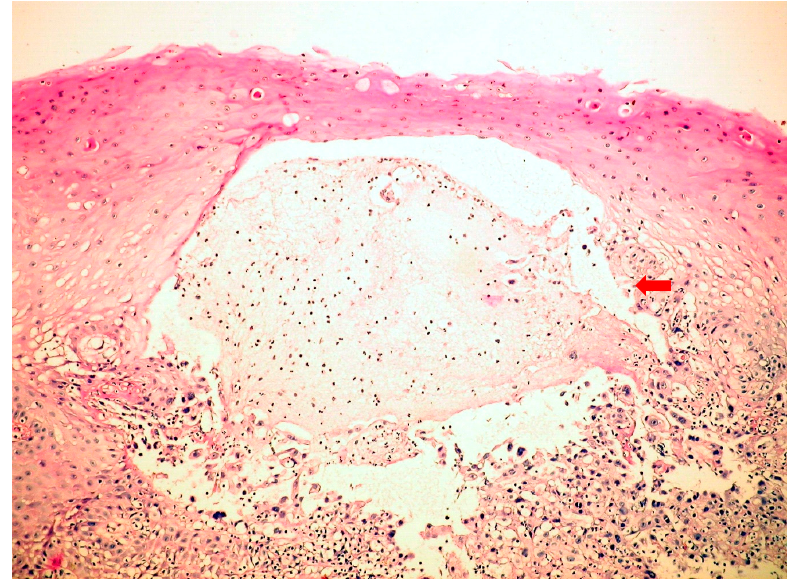
Figure 1. Herpes simplex virus (HSV)-inducedesophagitis (microscopy-HE, 400×) with serous vesicle formation.